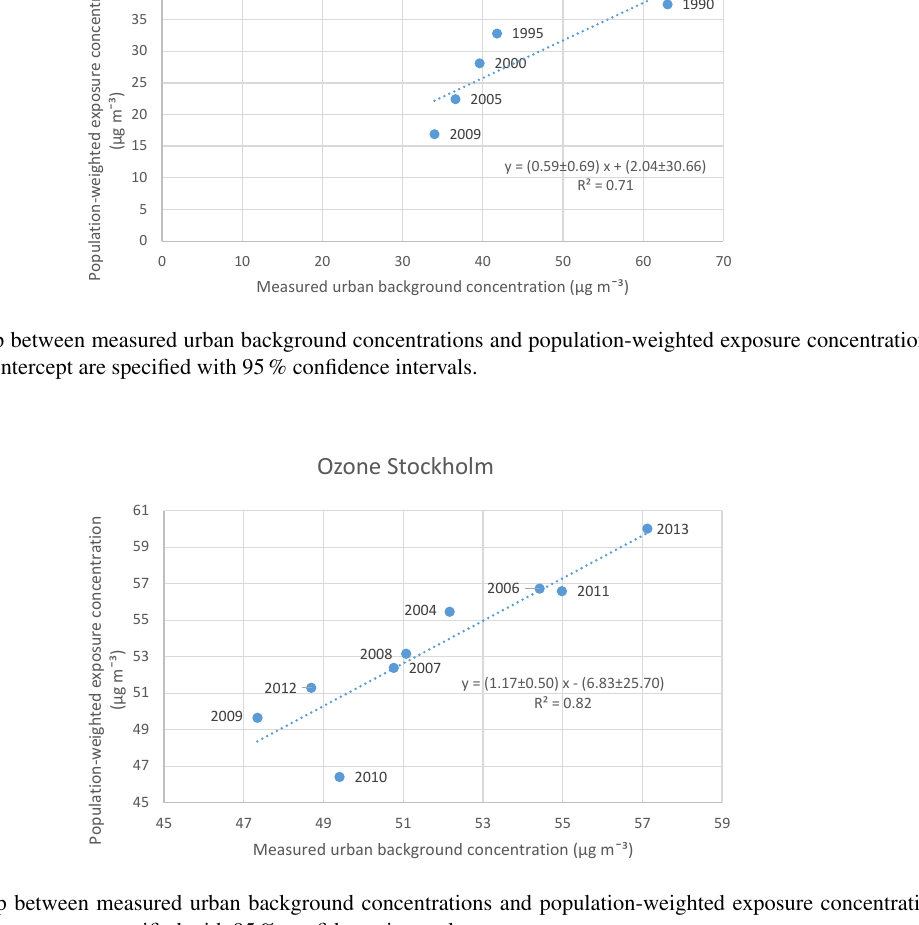
Figure A3. Relationship between measured urban background concentrations and population-weighted exposure concentrations of O 3 in Stockholm. Slope and intercept are specified with 95% confidence intervals.